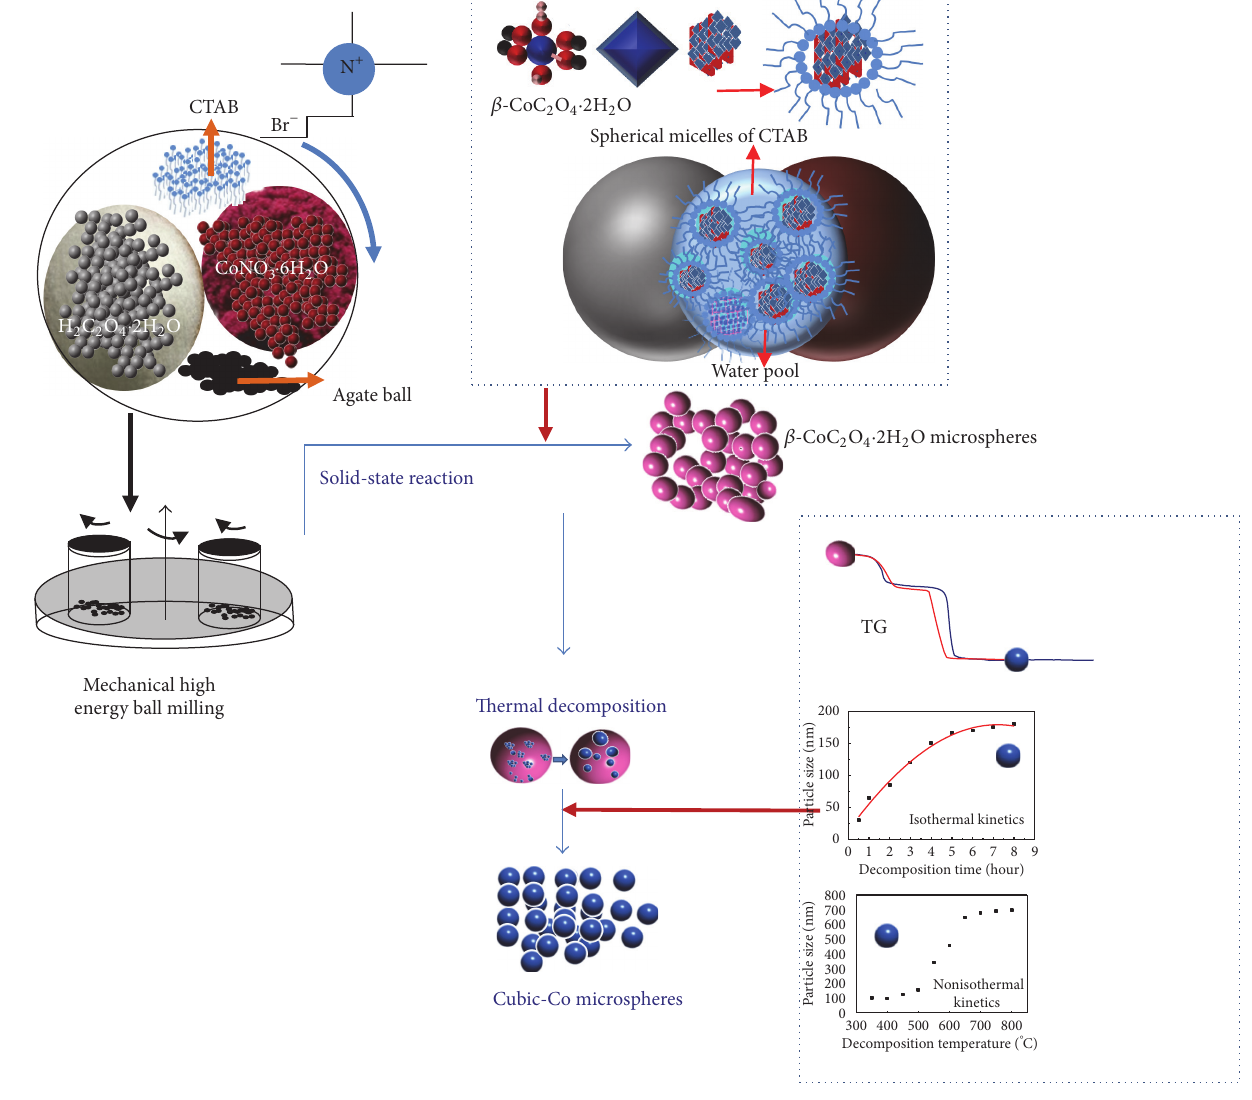
Figure 3: Schematic of the research